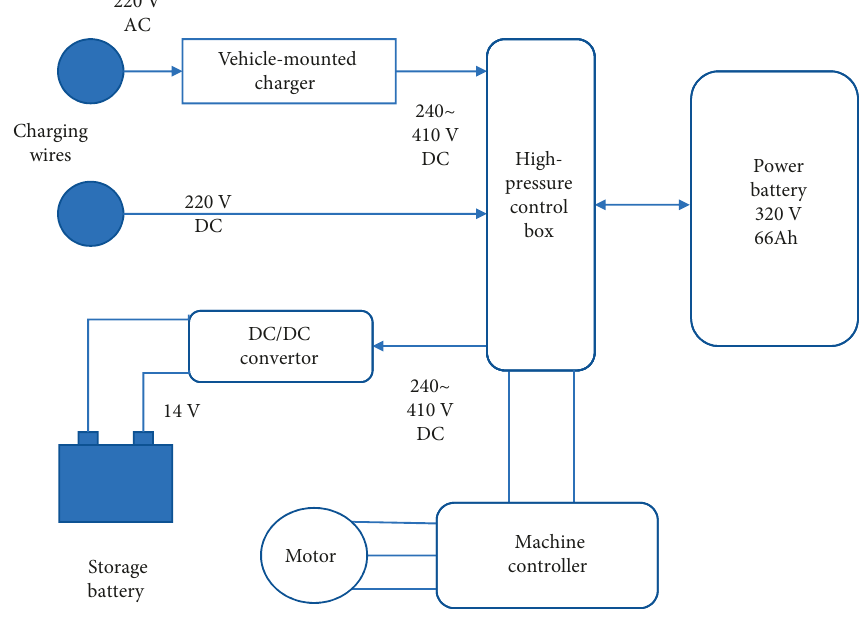
Figure 8: Electric vehicle power